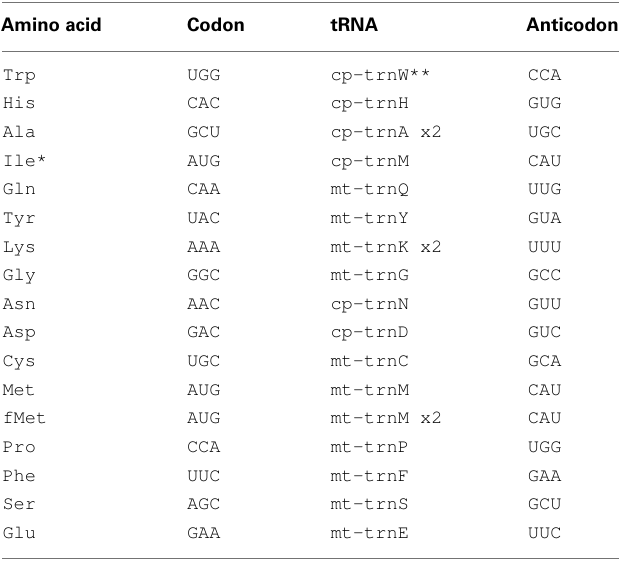
Table 1 | tRNA genes found in the mtDNA of Vicia